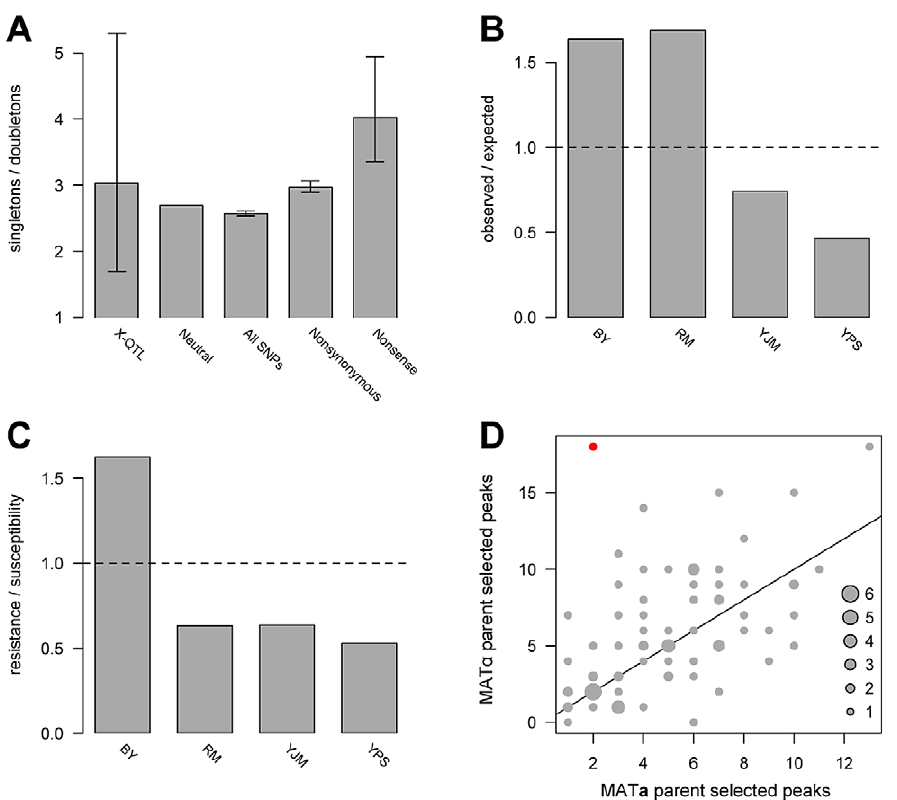
Figure 3. Population genetics of identified loci. (A) shows the ratios of singletons to doubletons observed in the X-QTL data and for different classes of sequence variation, (B) plots the ratio of observed X-QTL singletons to expected singletons by strain, (C) plots the ratio of resistance- conferring singletons to susceptibility-conferring singletons by strain, and (D) plots the directionalities of peaks detected in the 78 X-QTL selections. In A, the error bars denote 95% confidence intervals. For the maximum likelihood estimate of the ratio of singletons to doubletons among X-QTL loci, the confidence interval was determined from the likelihood surface. For classes of sites analyzed in the resequencing data, confidence intervals were obtained using bootstrapping. The neutral estimate (8/3) is derived from a folded allele frequency spectrum for n=4. The other three measurements were obtained directly from a multiple sequence alignment of the genome sequences of the four strains. In B, the number of expected allelic singletons per strain was determined by multiplying the total number of allelic singletons detected by the proportion of all SNP allelic singletons among the four strains present in that parental genome. The values in C were obtained from Table 1. The horizontal lines in B and C indicate a ratio of one. In D, the number of peaks selected in each direction in each X-QTL selection is plotted. One experiment—copper sulfate in the BYxRM cross— was significant for the sign test after a Bonferroni correction for multiple testing, indicating putative directional selection, and is shown in red. The number of experiments observed with a given number of up and down peaks is indicated by the size of a circle, with a key provided in the bottom right corner. The diagonal line in D shows a 1:1 ratio of peaks selected in the direction of each parent.